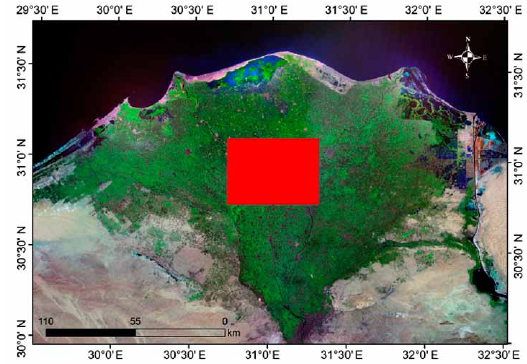
Fig. 1. Location of the study area in the middle Nile Delta of